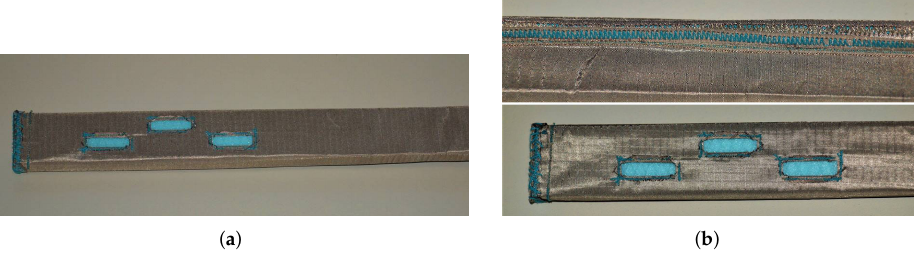
Figure 3. Prototype of the textile antenna ( a ) and details of sewing the waveguide, slots, and short- circuit ( b ).